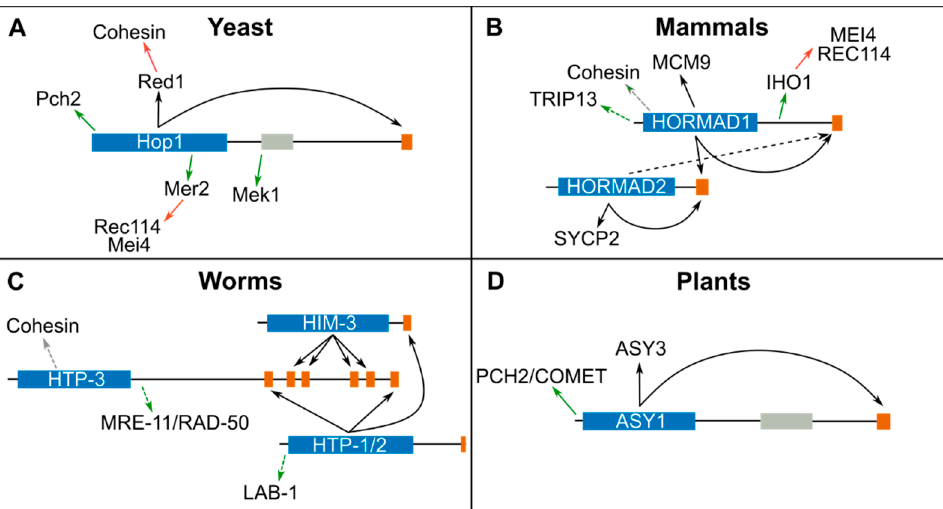
Figure 2. Summary of meiotic HORMAD interactors in yeast ( A ), mammals ( B ), worms ( C ) and plants ( D ). The HORMA domain of each protein is represented as a blue box and CMs by orange rectangles. Black arrows indicate interactions mediated through the safety belt-CM, green arrows indicate interactions through another interface, grey arrows indicate interactors through an unknown interface and red arrows indicate interactions not involving HORMADs. Interactions only supported by immunoprecipitation and/or fluorescence colocalization dependency are indicated with a dotted line (Table 2). See also Figure 3 for a representation of potential conformational changes in meiotic HORMADs.